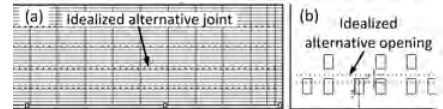
Table 1. Description of the six load cases.